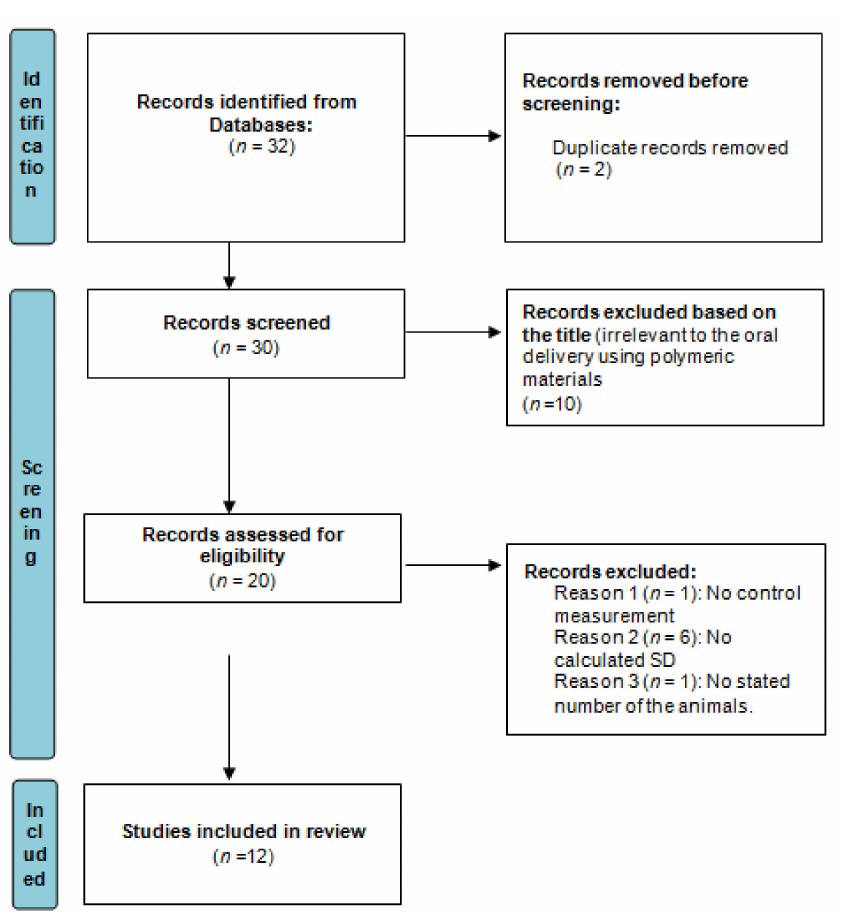
Figure 1. The process of data mining conducted in the current study, according to PRISMA